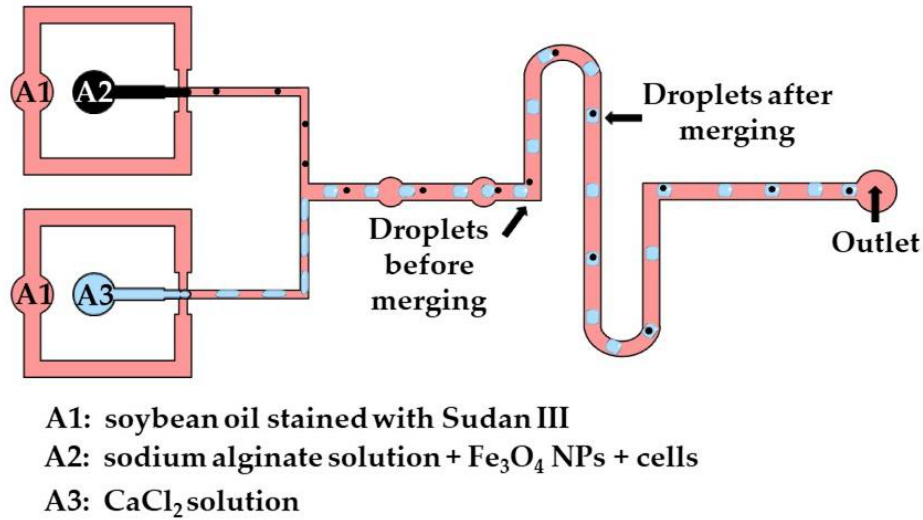
Figure 16. Formation of disk-like gel beads by merging the droplets of a Na-alginate solution loaded with cells and iron oxide NPs and droplets of the CaCl 2 solution. The disk-like shape is a consequence of droplet confinement in the vertical direction before crosslinking [67].